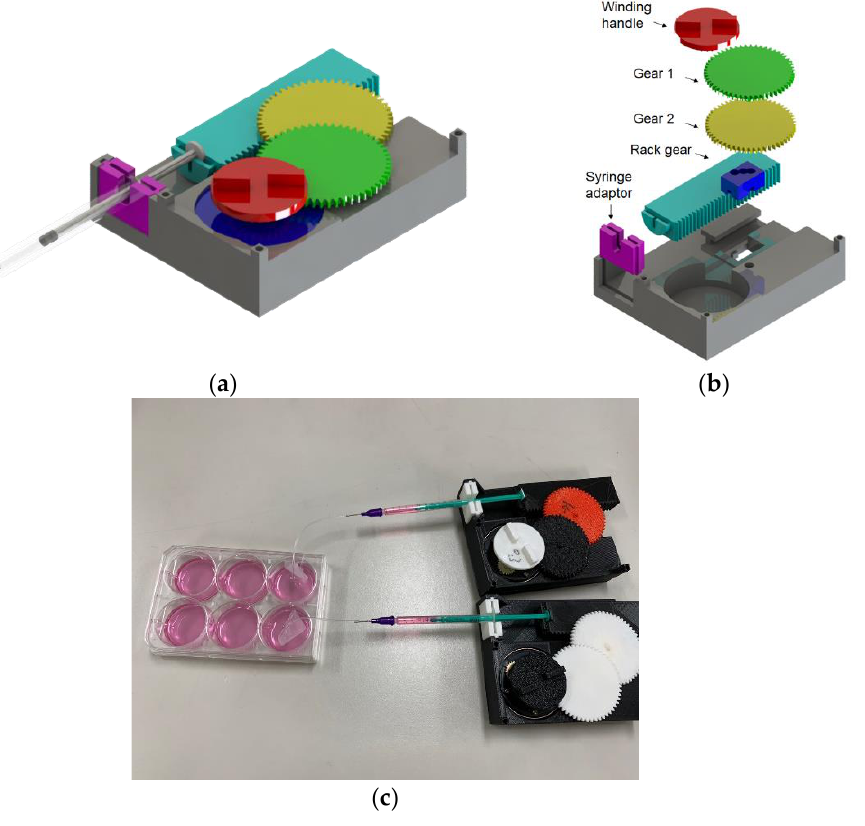
Figure 1. Illustration of the experimental setup. ( a ) CAD model of the color-coded assembled wind- up precision syringe pump. ( b ) CAD model of color-coded and 3D-printed wind-up syringe pump components. ( c ) A photo of two syringe pumps with 1 mL syringes used for cell treatment.